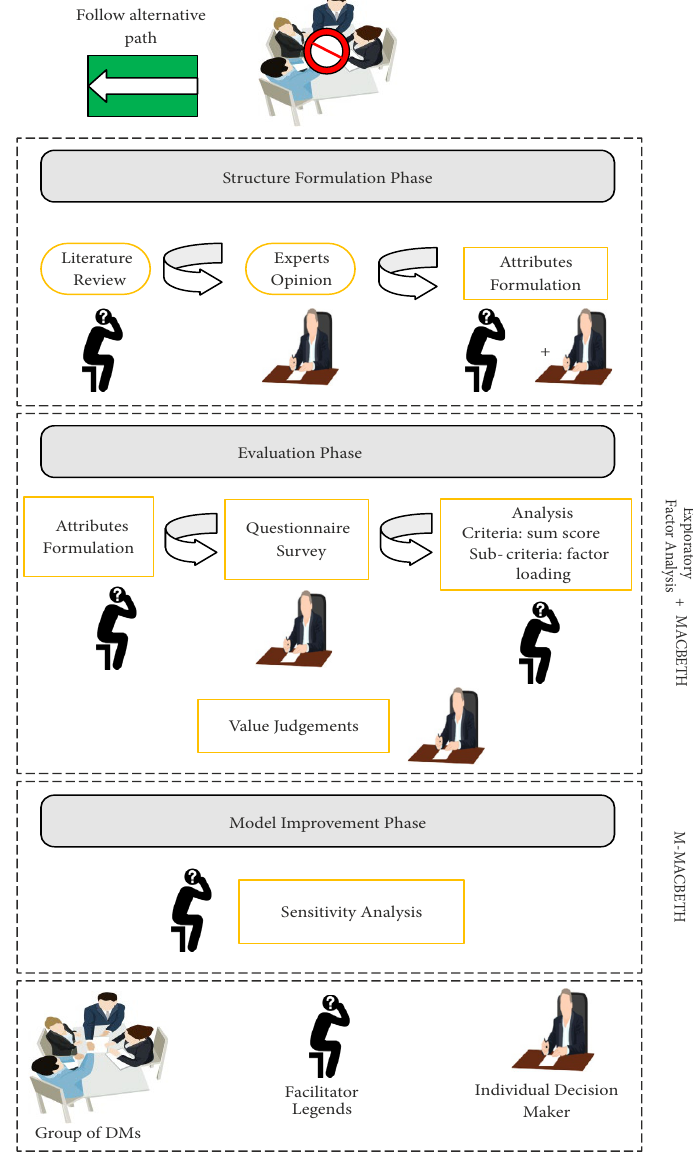
Figure 3. Proposed Embedded Remote Group Decision Making